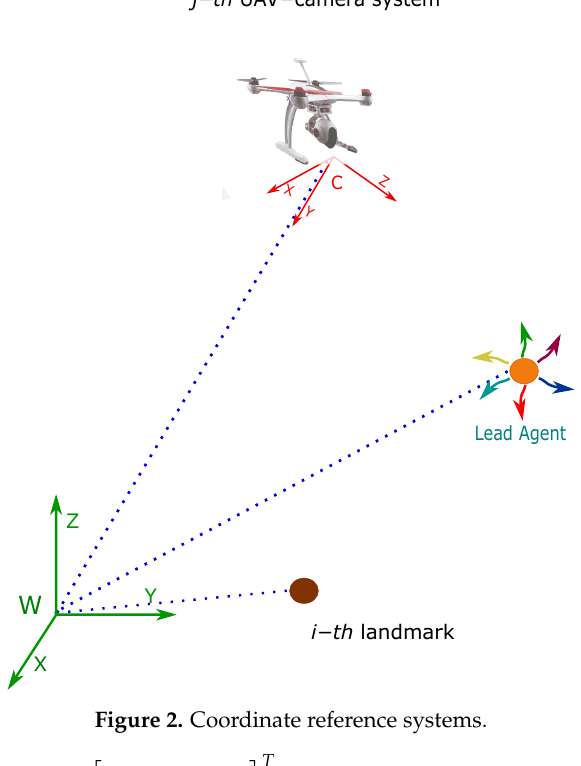
Figure 2. Coordinate reference